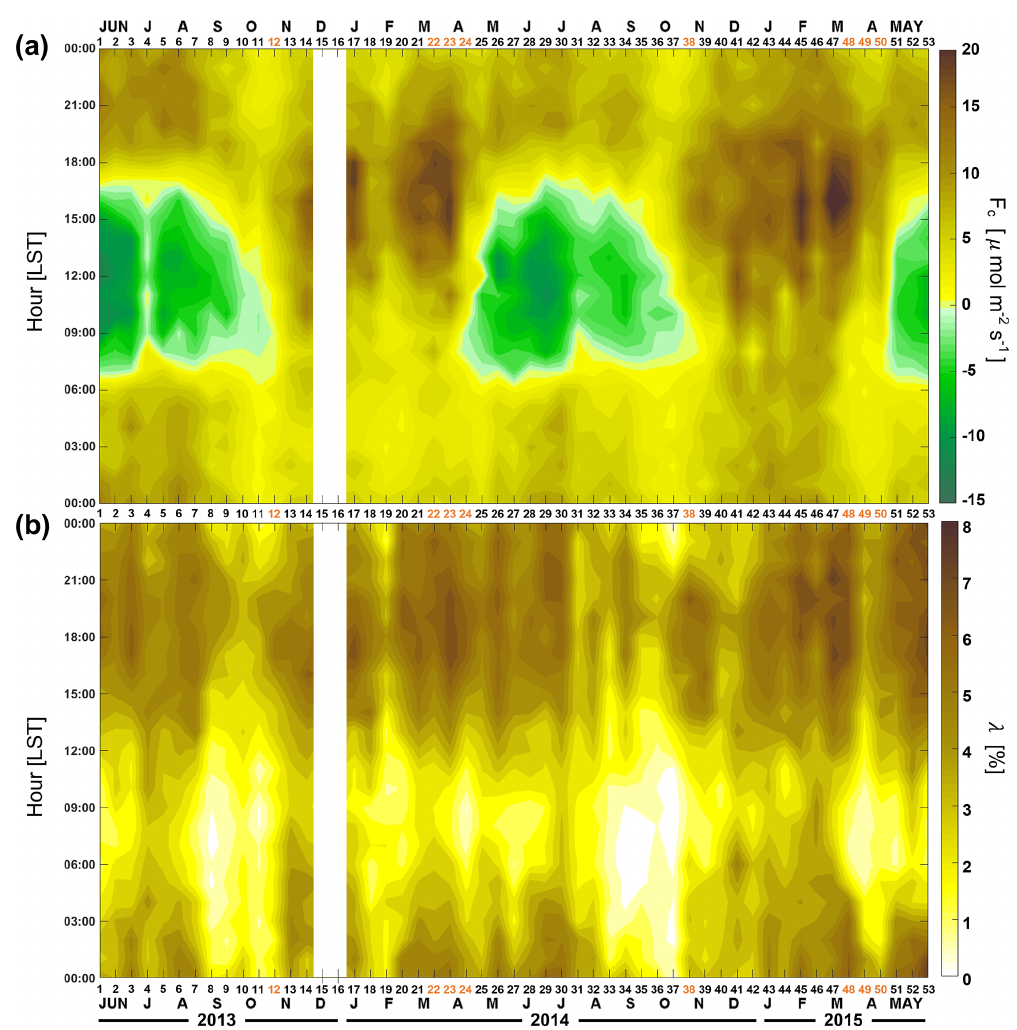
Figure 9. (a) Temporal variation of hourly averaged F C and (b) footprint-weighted road fraction ( λ) as every 2-week average ( x axis: the date; y axis: time of day). In December 2013, there was a gap for approximately 4 weeks due to the power system failure. The yellow numbers in the x axis indicate the transition period when traffic emissions ( E R ) contribute to the observed F C significantly.